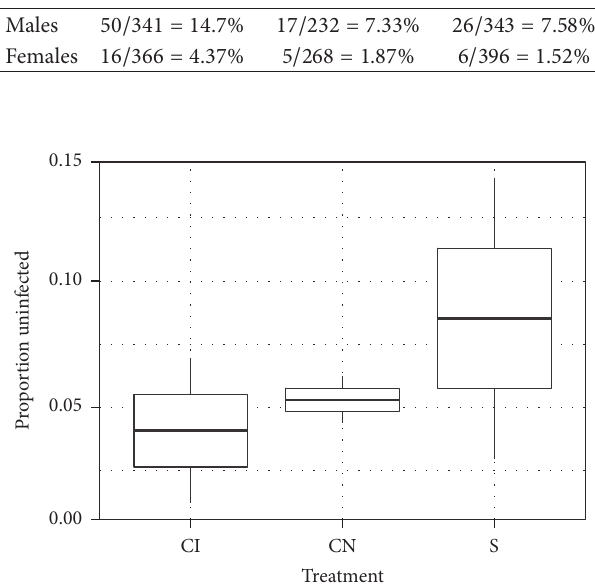
Figure 1: Box plot showing median and interquartile range of uninfected progeny (untransformed data) for each selection regime. Selective regimes included the following: CI (response to wound- ing), CN (the unperturbed control), and S (resistance to B. cereus infected). The median proportionof uninfected progeny was highest for the lines selected for resistance to Bacillus cereus.